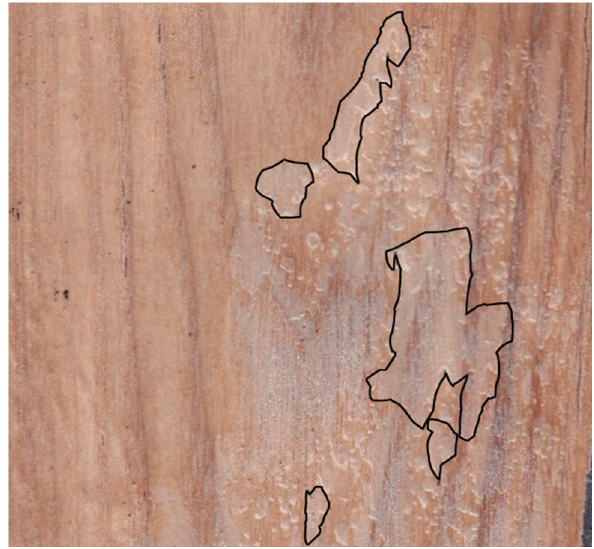
Figure 1. Cavity in polyethylene (PE) film reinforced veneer (Initial MC =